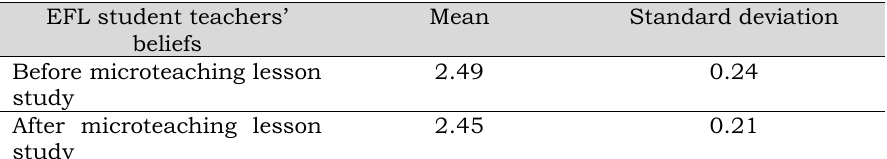
Table 1. The Mean and Standard